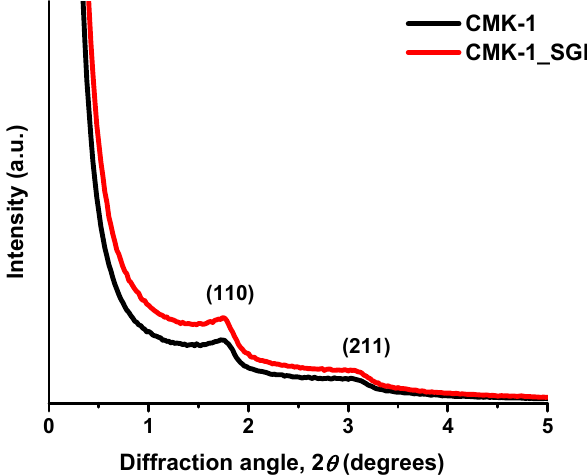
Figure 2. SAXS pattern of the CMK-1 carbon spheres before and after incubation with SGF.